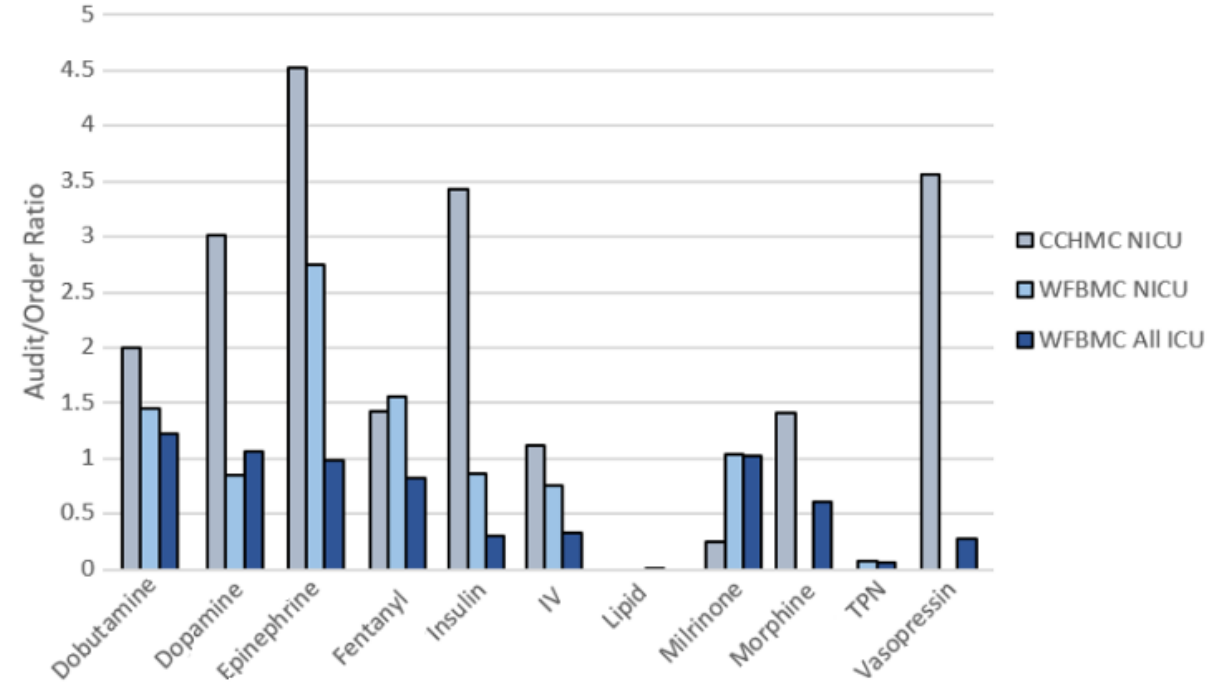
Figure 3 and Multimedia Appendices 3-5 present MAR/(order + audit) ratios between WFBMC departments and CCHMC NICU. The WFBMC NICU and all ICUs at WFBMC had comparable ratios. When compared to the CCHMC NICU, the ratios for WFBMC were higher for each studied medication. The average ratio for WFBMC NICU was 23.6 and the average